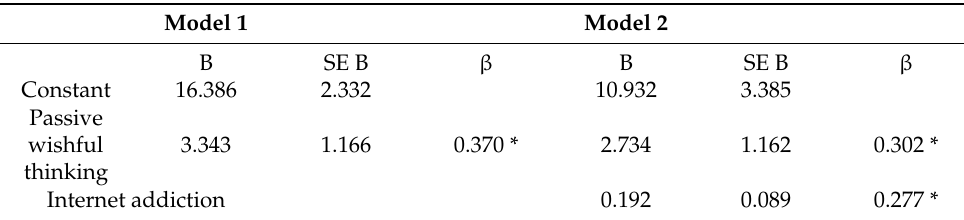
Table 5. Multiple regression to predict dysfunctional negative emotions from Internet addiction and passive wishful